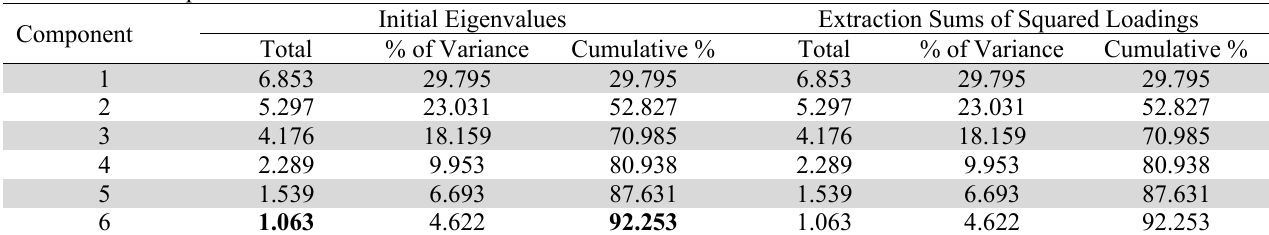
Total Variance Explained Initial Eigenvalues Extraction Sums of Squared Component